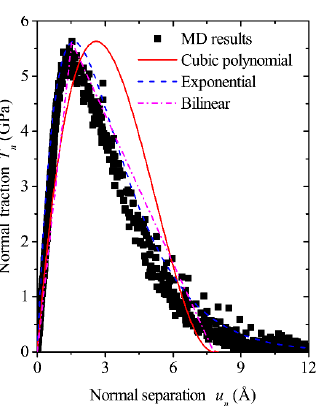
Figure 4. Normal traction–separation curves obtained from MD simulations and predicted by cohesive zone models.